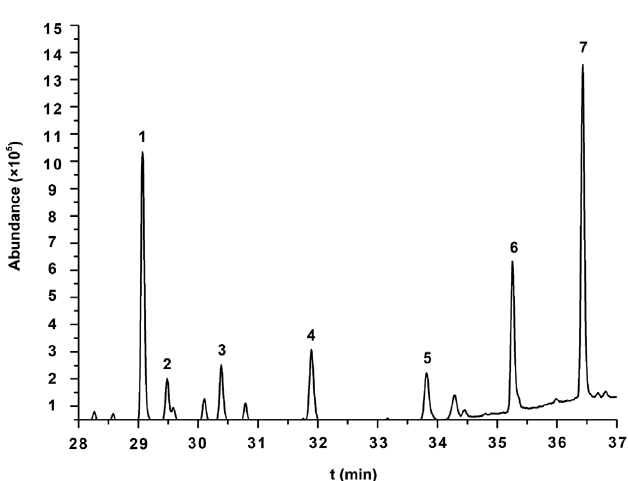
Fig. 6: Total ion chromatogram obtained with the GC-MS of fatty acid methyl esters of TY02. (1) C16:0, (2) C16:1, (3) C16:2, (4) C16:3, (5) C18:0, (6) C18:2, (7) C18:3.